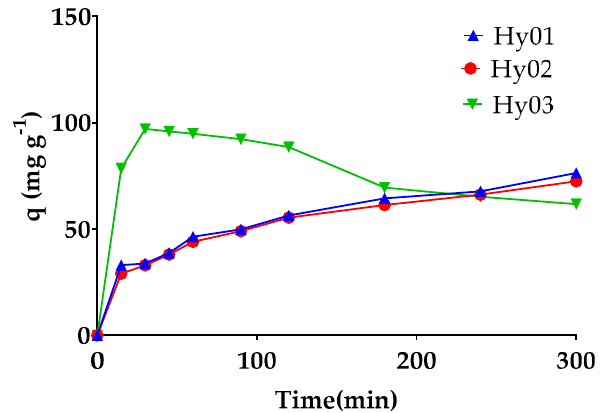
Figure 8. Removal of MO as a function of time when containing different concentrations of CNF at pH 7.64.